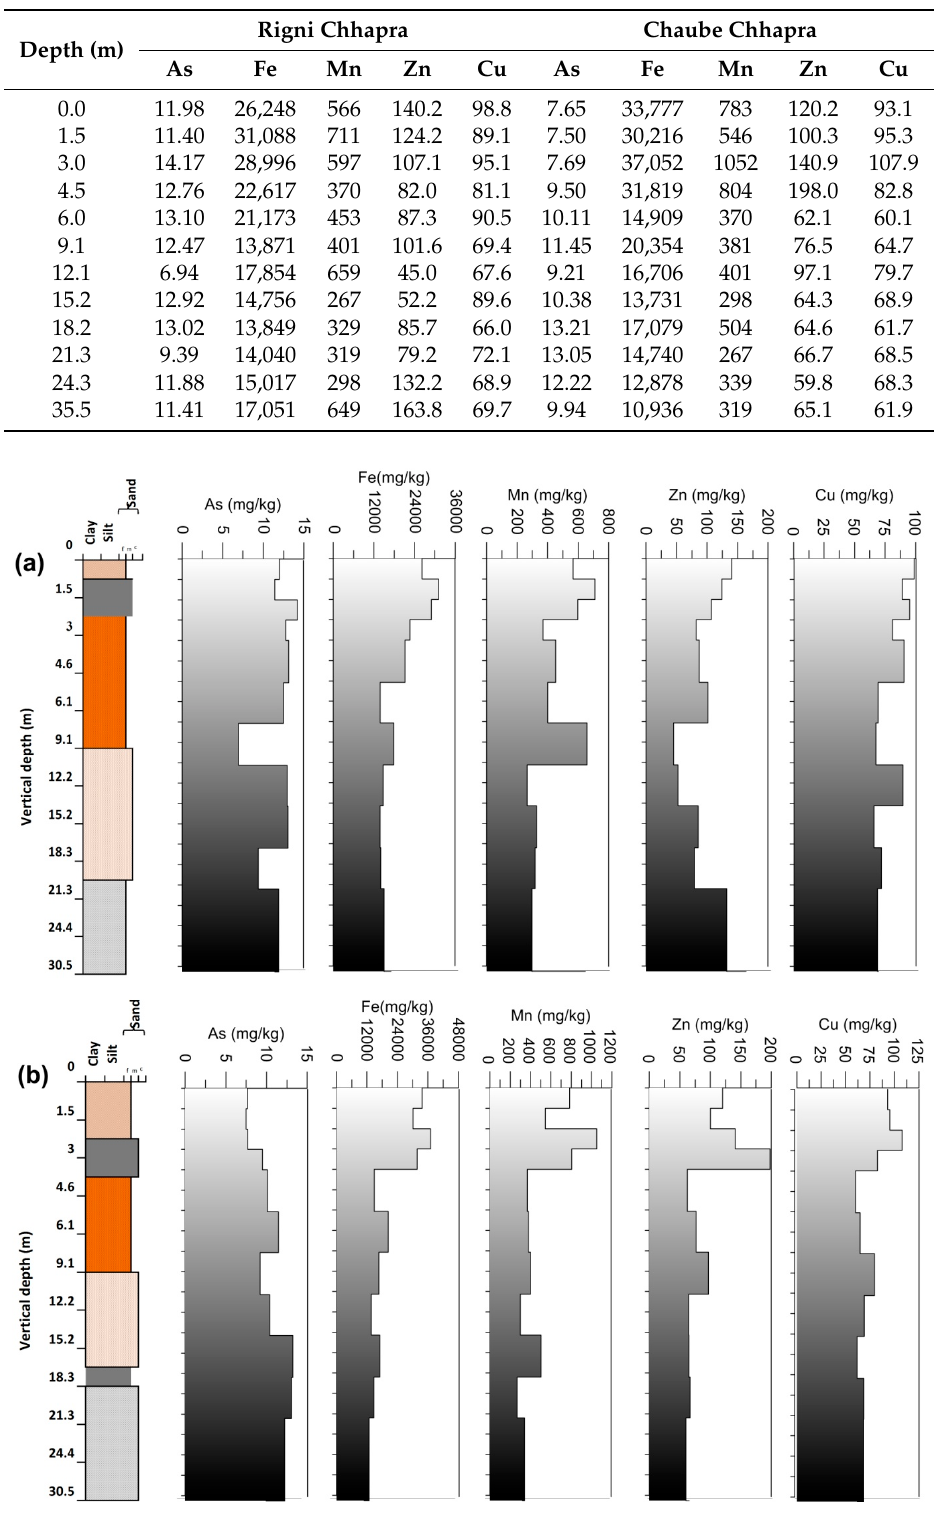
Figure 4. Vertical variability of As and other elements (Fe, Mn, Zn, and Cu) distribution in ( a ) Rigni Chhapra ( b ) Chaube Chhapra. Table 2. The concentration of As and other elements in (mg/kg) dry wt. extracted from core sediments vertical below at Rigni Chhapra and Chaube Chhapra.